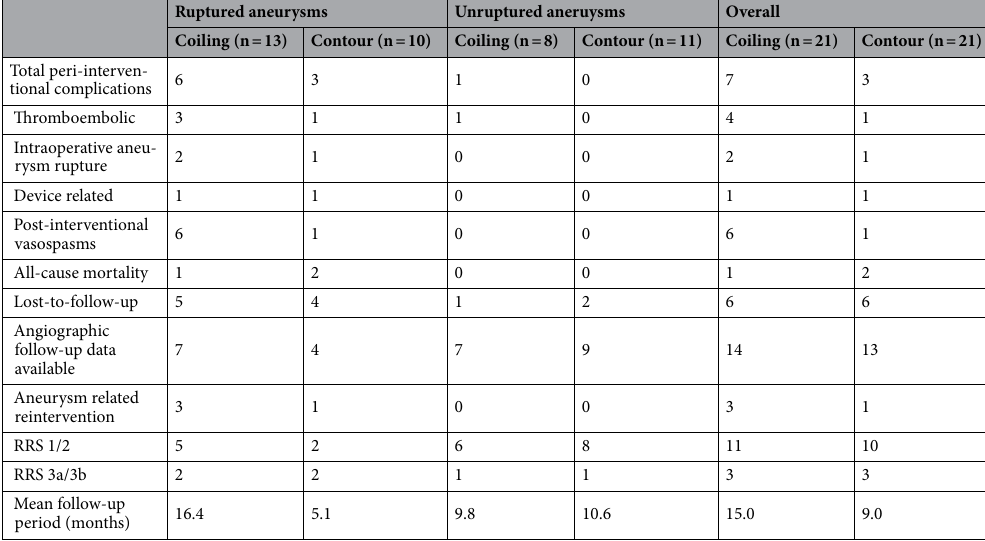
Table 3. Summary of peri-interventional complications and follow-up results at latest